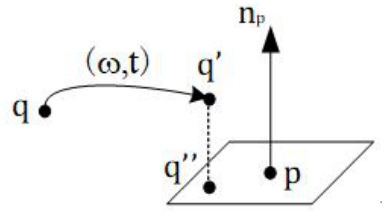
Figure 4. The space relationship of the